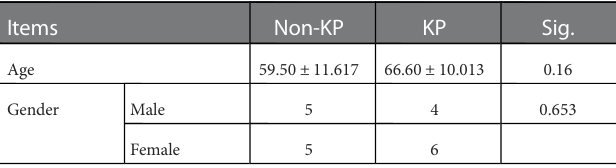
TABLE 4 Basic information of the patients who met the end point. Items